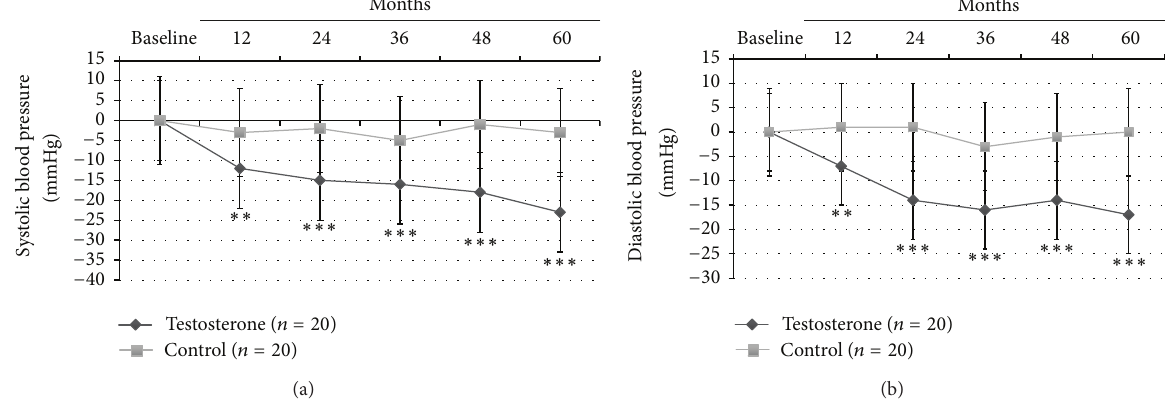
Figure 2: Effects of 5-year treatment with long-acting TU on (a) systolic blood pressure (mmHg) and (b) diastolic blood pressure (mmHg) in 40 hypogonadal men (T < 11nmol/L) with metabolic syndrome (IDF). 𝑃 variations were evaluated yearly in the testosterone treatment (TRT) versus controls